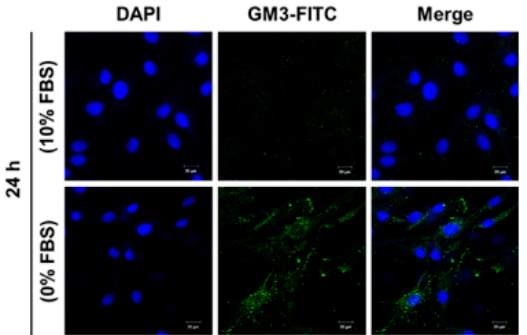
Figure 5. Confocal analysis of ganglioside GM3 expression in SD-induced MG-63 cells. After incubation for 24 h in standard medium containing 10% FBS or 0% FBS, cells were immunostained with anti-GM3 antibodies (FITC; green). Nuclei were stained with DAPI (blue) and analyzed by confocal microscopy. Scale bar: 20 μ m.